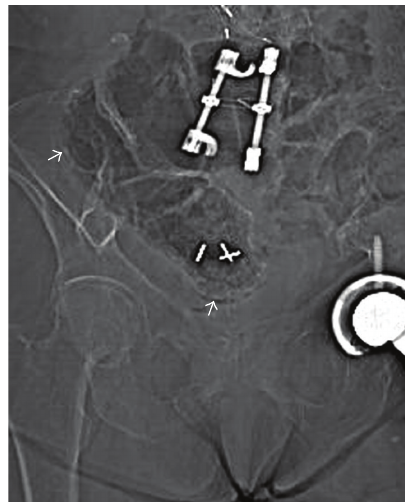
Figure 1: Scout film from abdominaland pelvic CT scan shows cre- centic lucencies in the walls of the stool-filled cecum and ascending colon, compatible with pneumatosis.